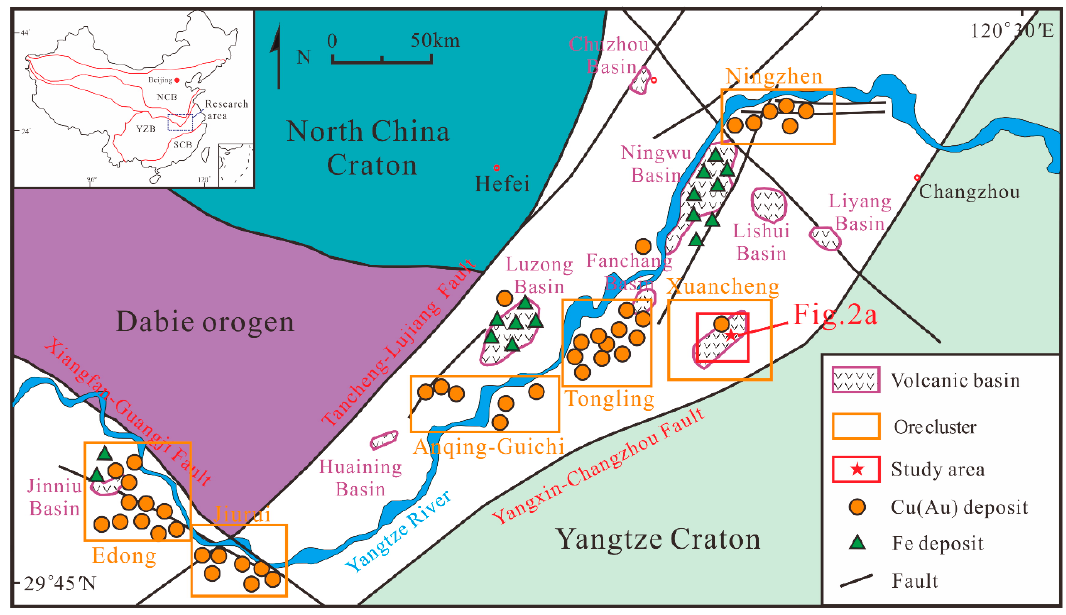
Figure 1. Geological scheme, including volcanic basins and ore cluster regions in the Middle-Lower Yangtze River Metallogenic Belt (MLYRB) (modified after [9]).